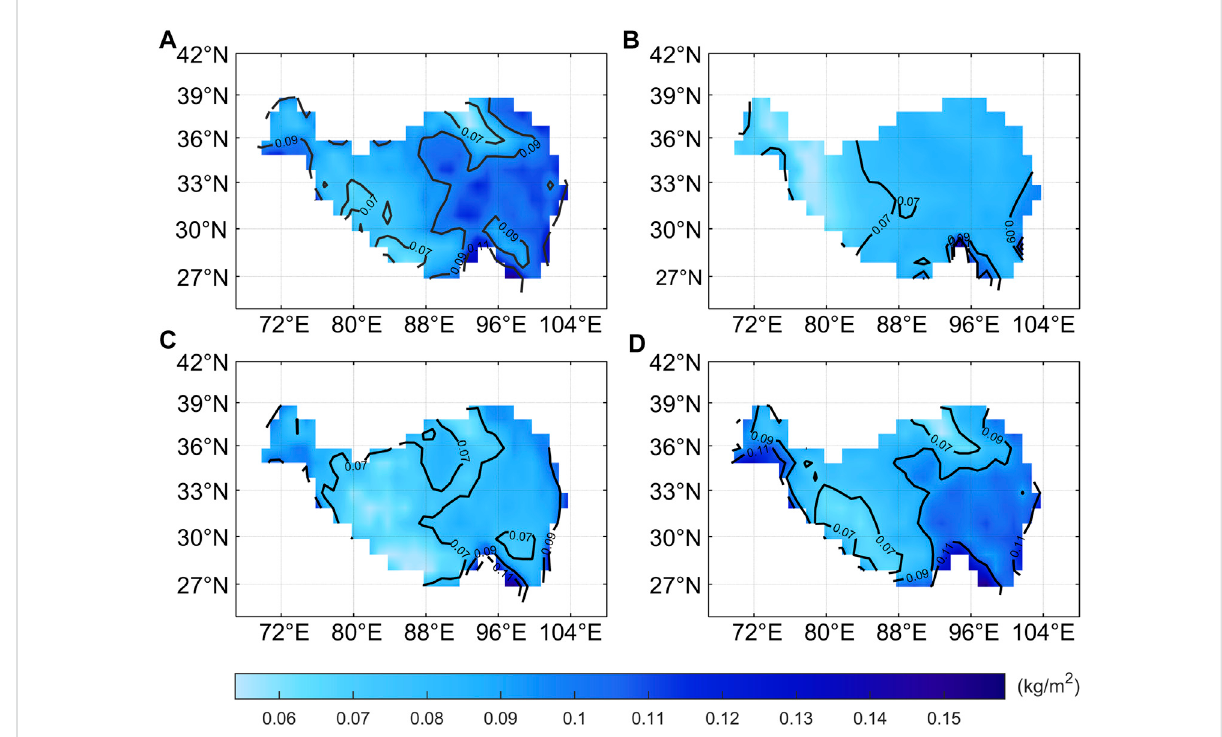
FIGURE 1 Spatial distributions of atmospheric ice over the TP retrieved by (A) Aqua, (B) ERA5, (C) Terra and (D) Suomi NPP NOAA-20 from 2013 to